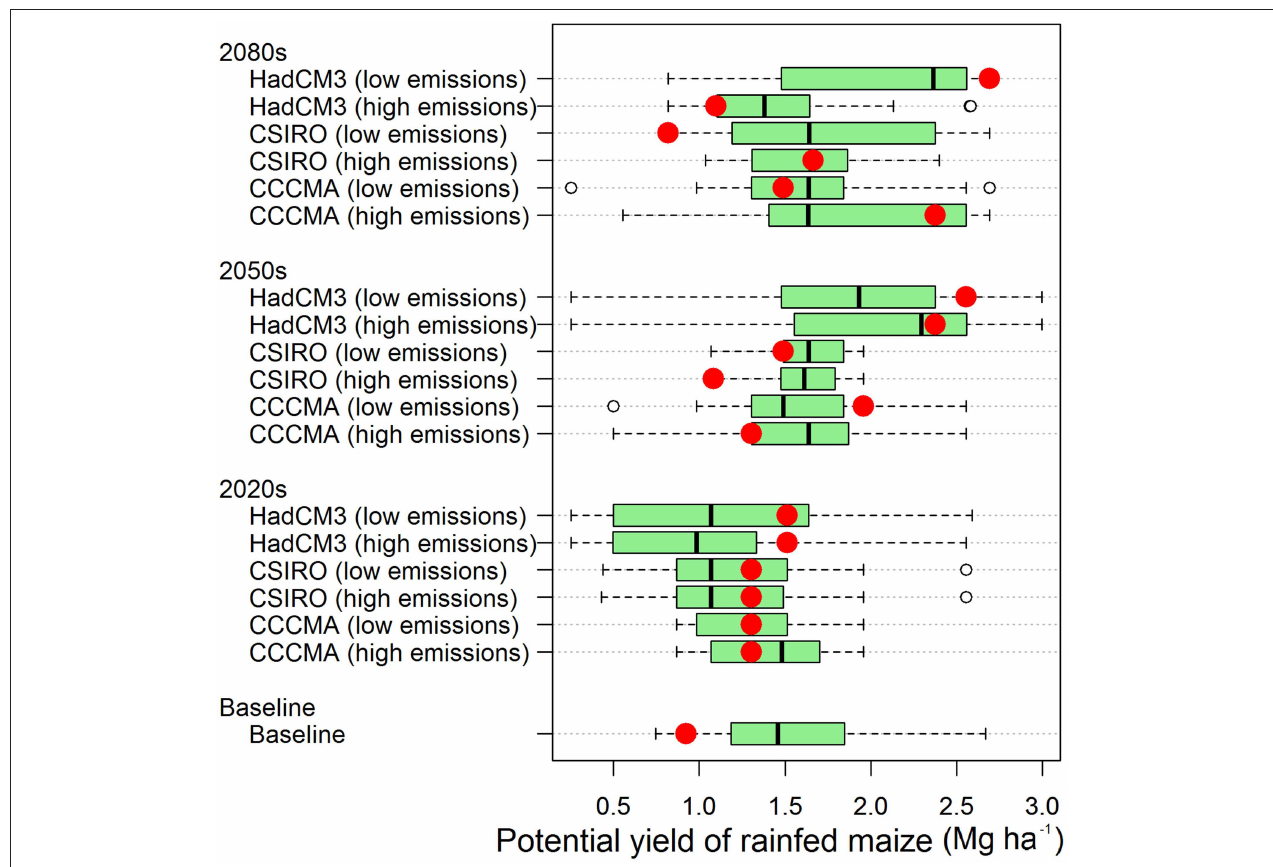
FIGURE 7 | Distributions of maize yield potentials among 50 candidate climate analog locations of the baseline site on Mt. Elgon, Kenya, for each of 18 future climate scenarios. The 50 sampled sites are those grid cells where the current climate was most similar to the projected future climate at the baseline location, for the respective climate scenario. Low emissions refers to the B2a and high emissions to the A2a greenhouse gas emissions pathway. Red dots mark the closest